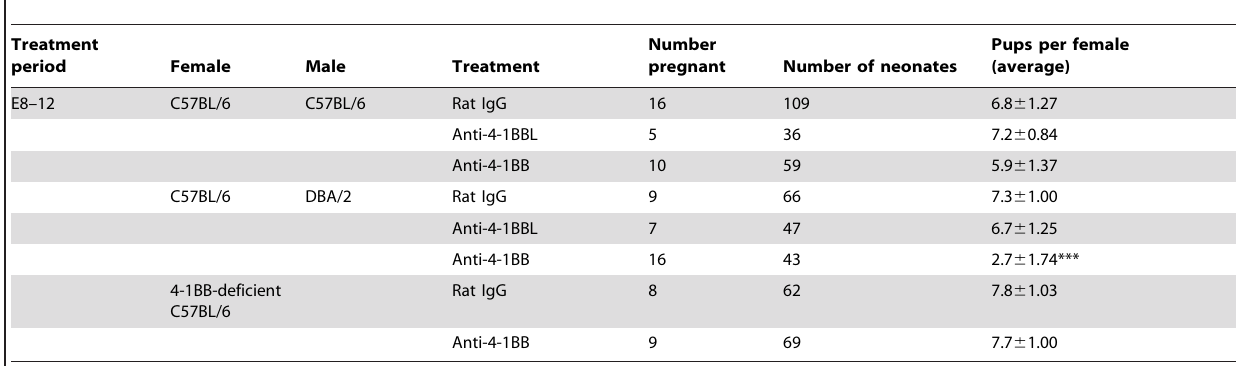
Table 1. Effect of the 4-1BB-4/1BBL interaction on allogeneic and syngeneic concepti.